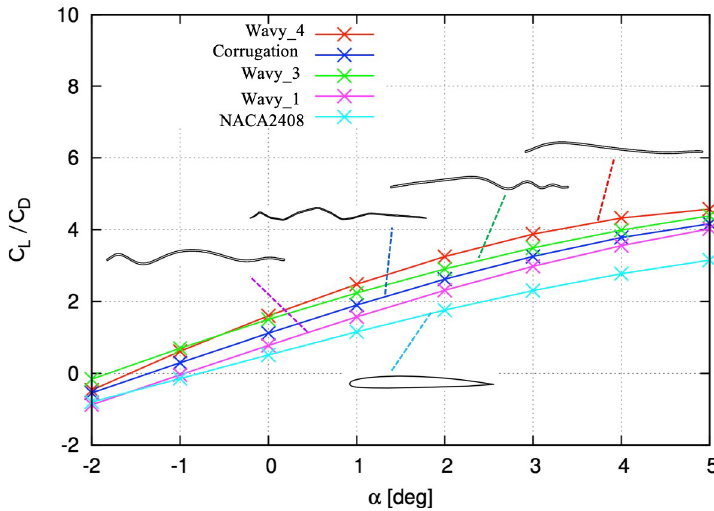
Figure 15. Flow past various geometries at Re = 10 3 : variation with angle of attack of time-averaged lift-to-drag